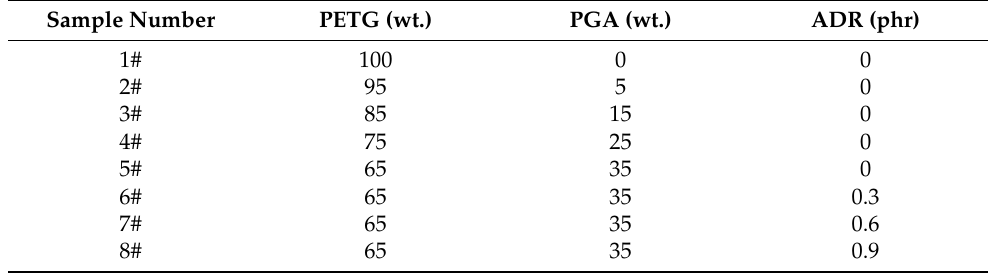
Table 1. Compositions of PETG/PGA (y/z) and PETG/PGA/ADR (65/35/x) samples.